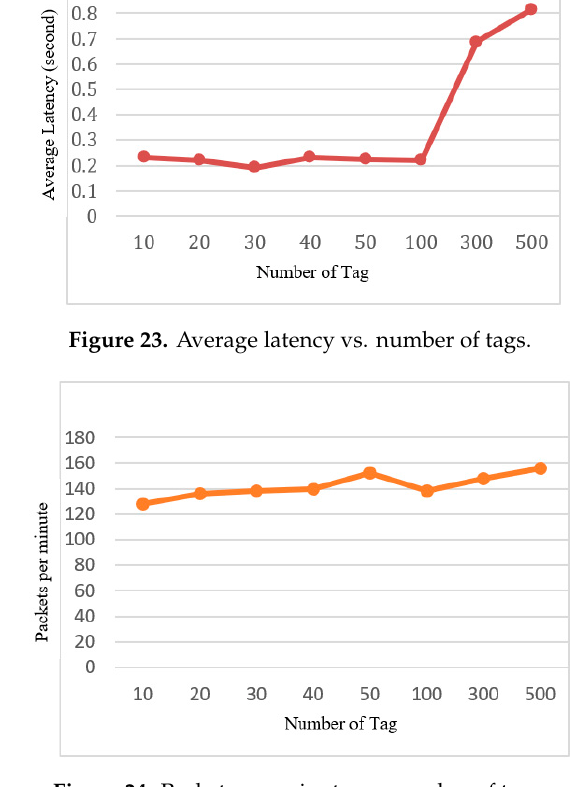
Figure 24. Packets per minute vs. number of tags.